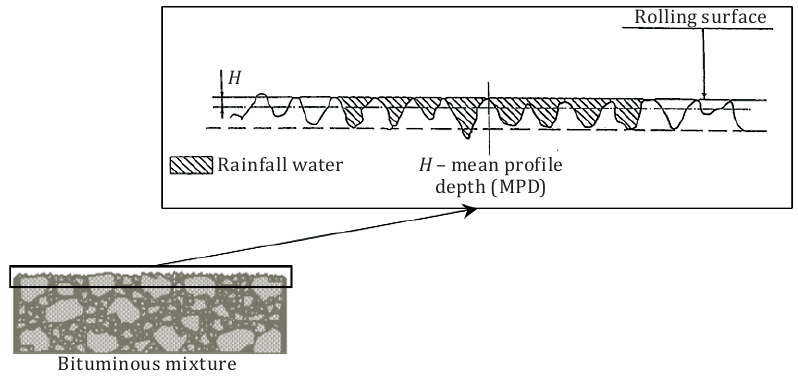
Figure 23. Rainfall water in the pavement